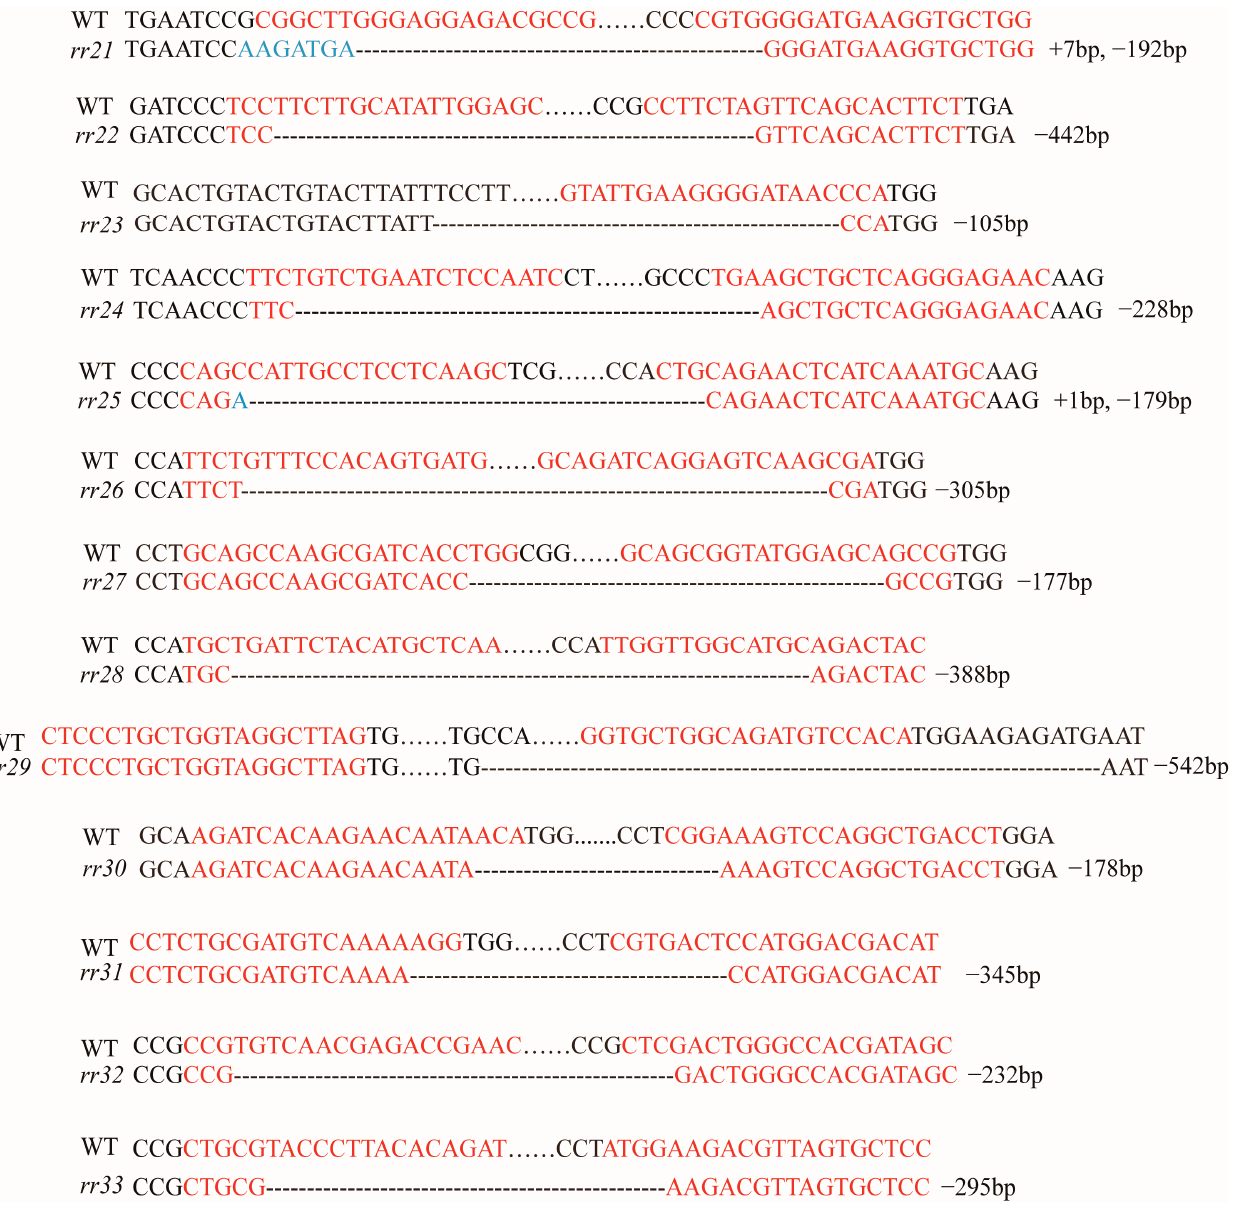
Figure 5. Mutation of type-B OsRRs in detail. The target sequences were red characters, and — indicates the bases deleted in the mutants.